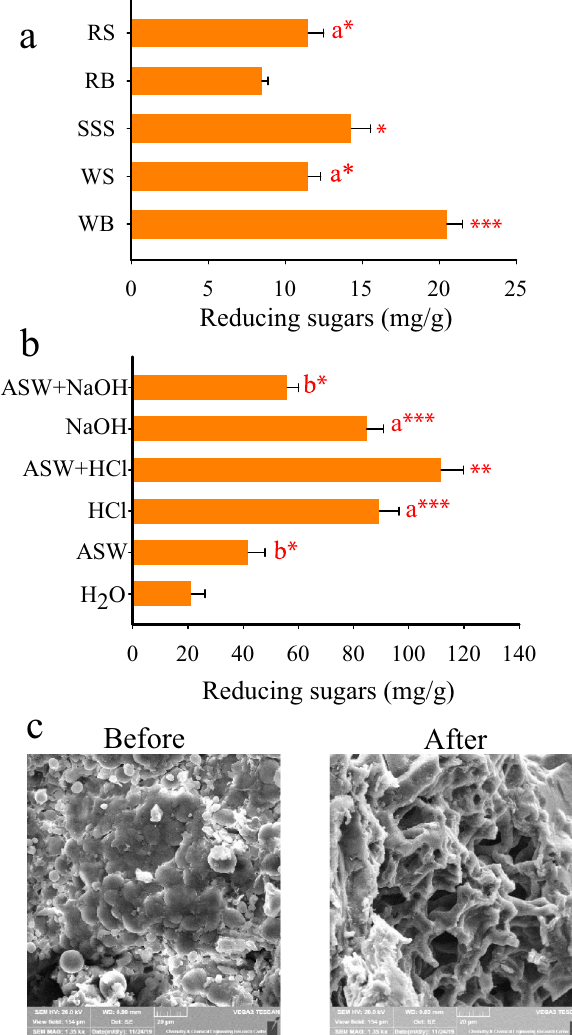
Figure 4. ( a ) Activity of Xyn-2 on wheat bran (WB), wheat straw (WS), sunflower-seed shell (SSS), rice bran (RB), and rice straw (RS). One mg of each biomass was treated with 100 μl (1.35 U) of crude enzyme for one hour at 20 °C. The activity of Xyn-2 on the substrates was analyzed by the measurement of reducing sugars. ( b ) Effects of various pretreatments including artificial seawater (ASW), hydrochloric acid (0.3% HCl), artificial seawater plus HCl (ASW + 0.3% HCl), sodium hydroxide (0.1% NaOH), and artificial seawater plus NaOH (ASW + 0.1% NaOH) on digestibility of wheat bran by Xyn-2. The effects were analyzed by the measurement of reducing sugars released as a result of the enzyme activity. ( c ) Electron micrographs of wheat bran pretreated with artificial seawater plus HCl before and after Xyn-2 hydrolysis. The significance of the difference in sugar concentration between nearby values is indicated by stars at p ≤ 0.001 (***), p ≤ 0.01 (**), and p ≤ 0.05 (*). The letters (a and b) indicate that there is no significant difference between means of the same